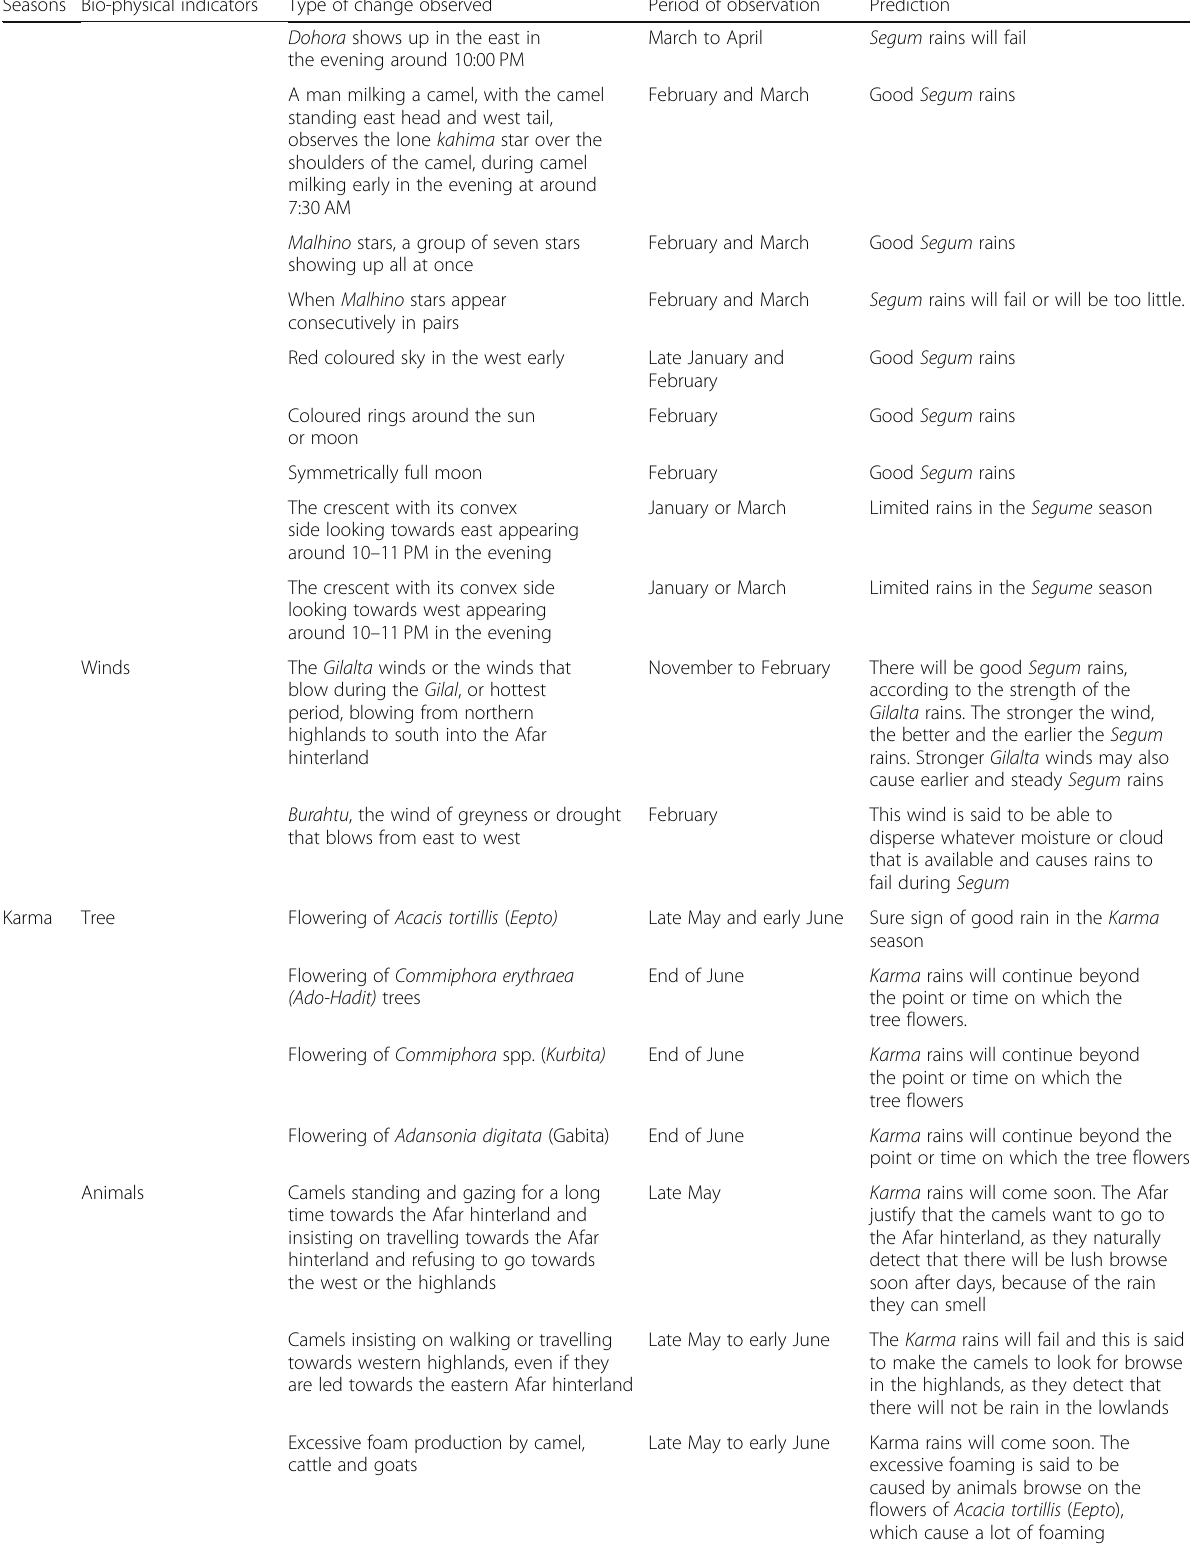
Table 3 Season-specific bio-physical indicators of indigenous weather prediction by Afar pastoralists (Continued) Seasons Bio-physical